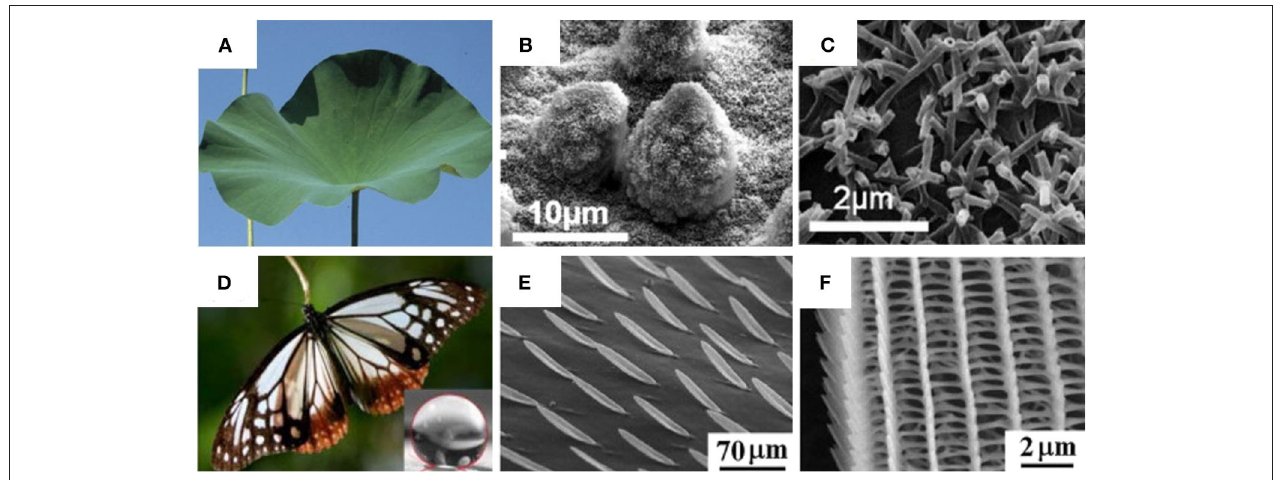
FIGURE 1 | Figure showing digital images and scanning electron microscopy (SEM) images of different natural species that display hydrophobic properties: (A–C) Nelumbo nucifera (lotus); (D–F) P. sita butterfly wings. (A–C) Adapted from Koch et al. (2009) and (D–F) Adapted from Perez Goodwyn et al. (2009). With permission from Elsevier and NPG (2009),